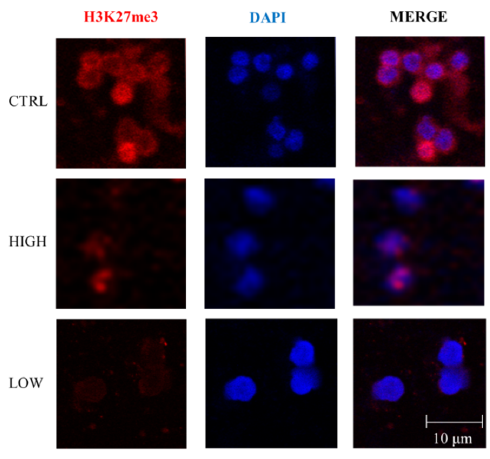
Figure 4. High nSOD1 induces an increase in H3K27 methylation. Representative images of trimethy- lation of histone 3 on lysine 27 (H3K27me3) investigated through immunofluorescence in PBMCs of controls ( n = 2) and high-nSOD1 ( n = 2) and low-nSOD1 ( n = 2)